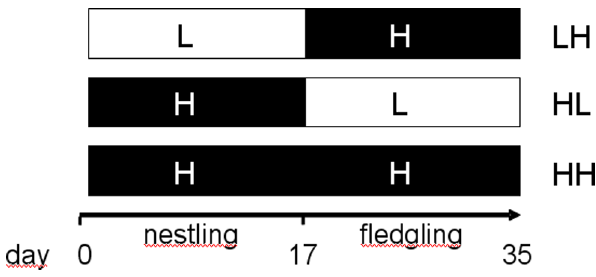
Figure 1. Overview of experimental treatments and time course. The three experimental groups received a low (L) or a high (H) quality rearing diet in different order during their first month post hatching. The low-high (LH) group received low quality food from day 3 until day 17 and high quality food from day 17 until day 35 (=breeding earlier than optimal). The high-low (HL) group received high quality food from day 3 until day 17 and low quality food from day 17 until day 35 (breeding later than optimal). The high-high (HH) group received high quality food from day 3 until day 35 (optimal timing of breeding).